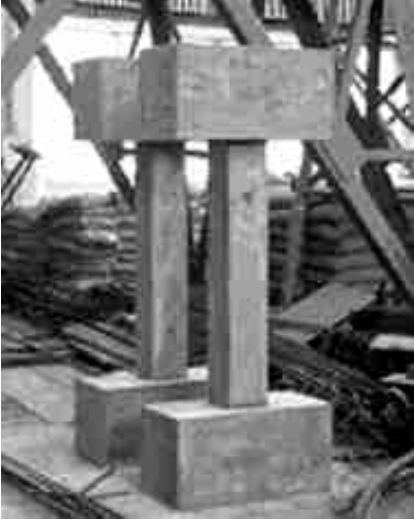
Fig. 2 The molded test piece